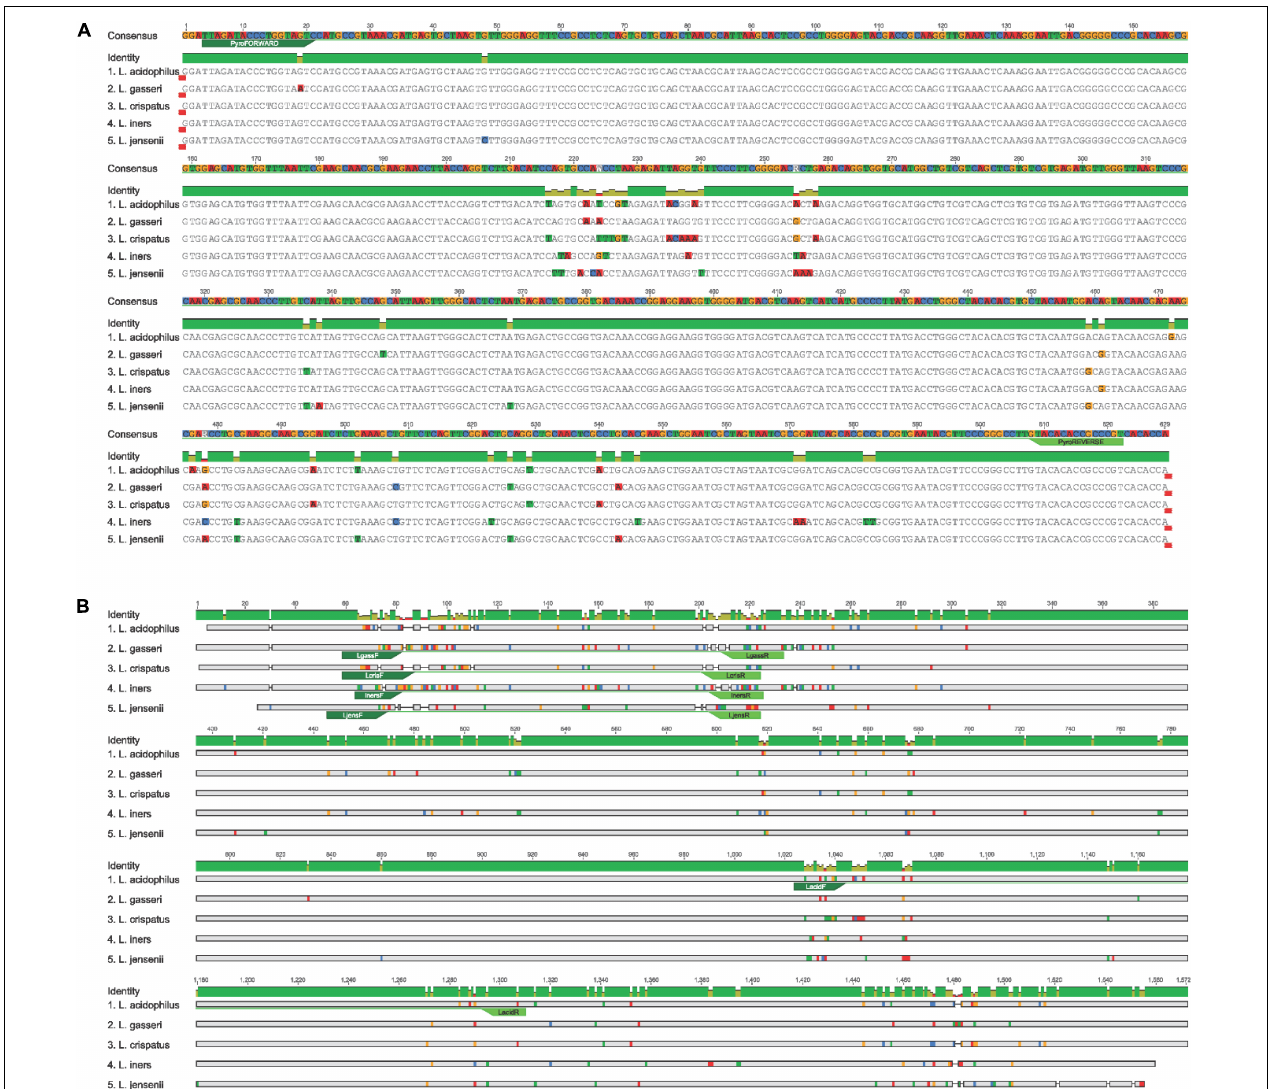
FIGURE 1 | (A) Annealing site of NGS 16S rRNA primers to V5-V8 region in the Lactobacillus species. (B) Lactobacillus species-specific primers annealing sites used for qPCR